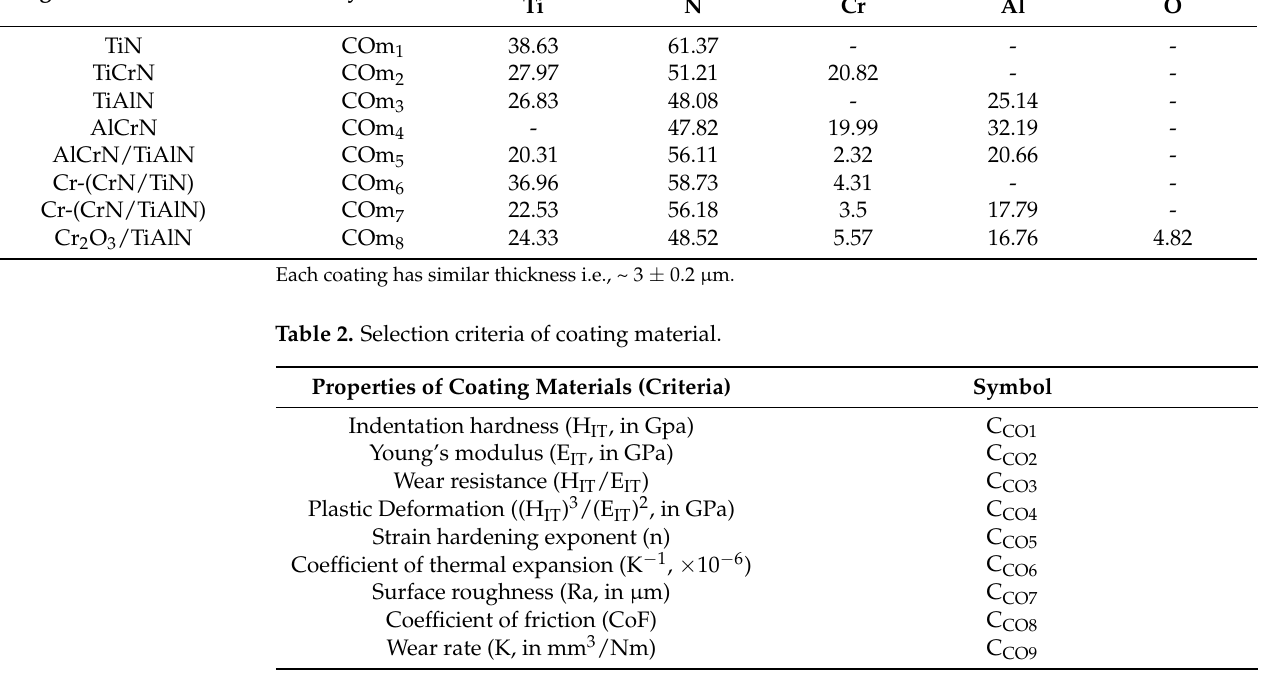
Table 3. Initial fuzzy diction matrix for evaluating the coating material